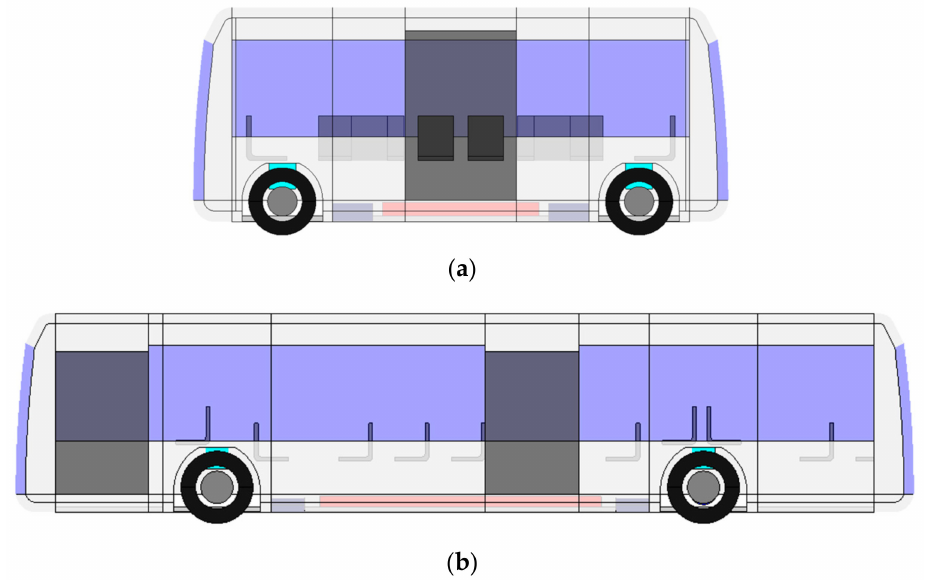
Figure 4. Vehicle package visualization of a 6 m AEB ( a ) and 12 m AEB ( b